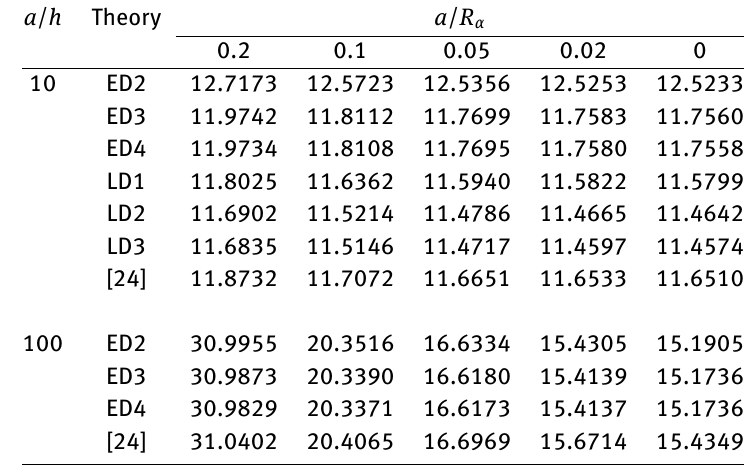
√︁ ρ of [0/90/0] SSSS spherical panels. E 2